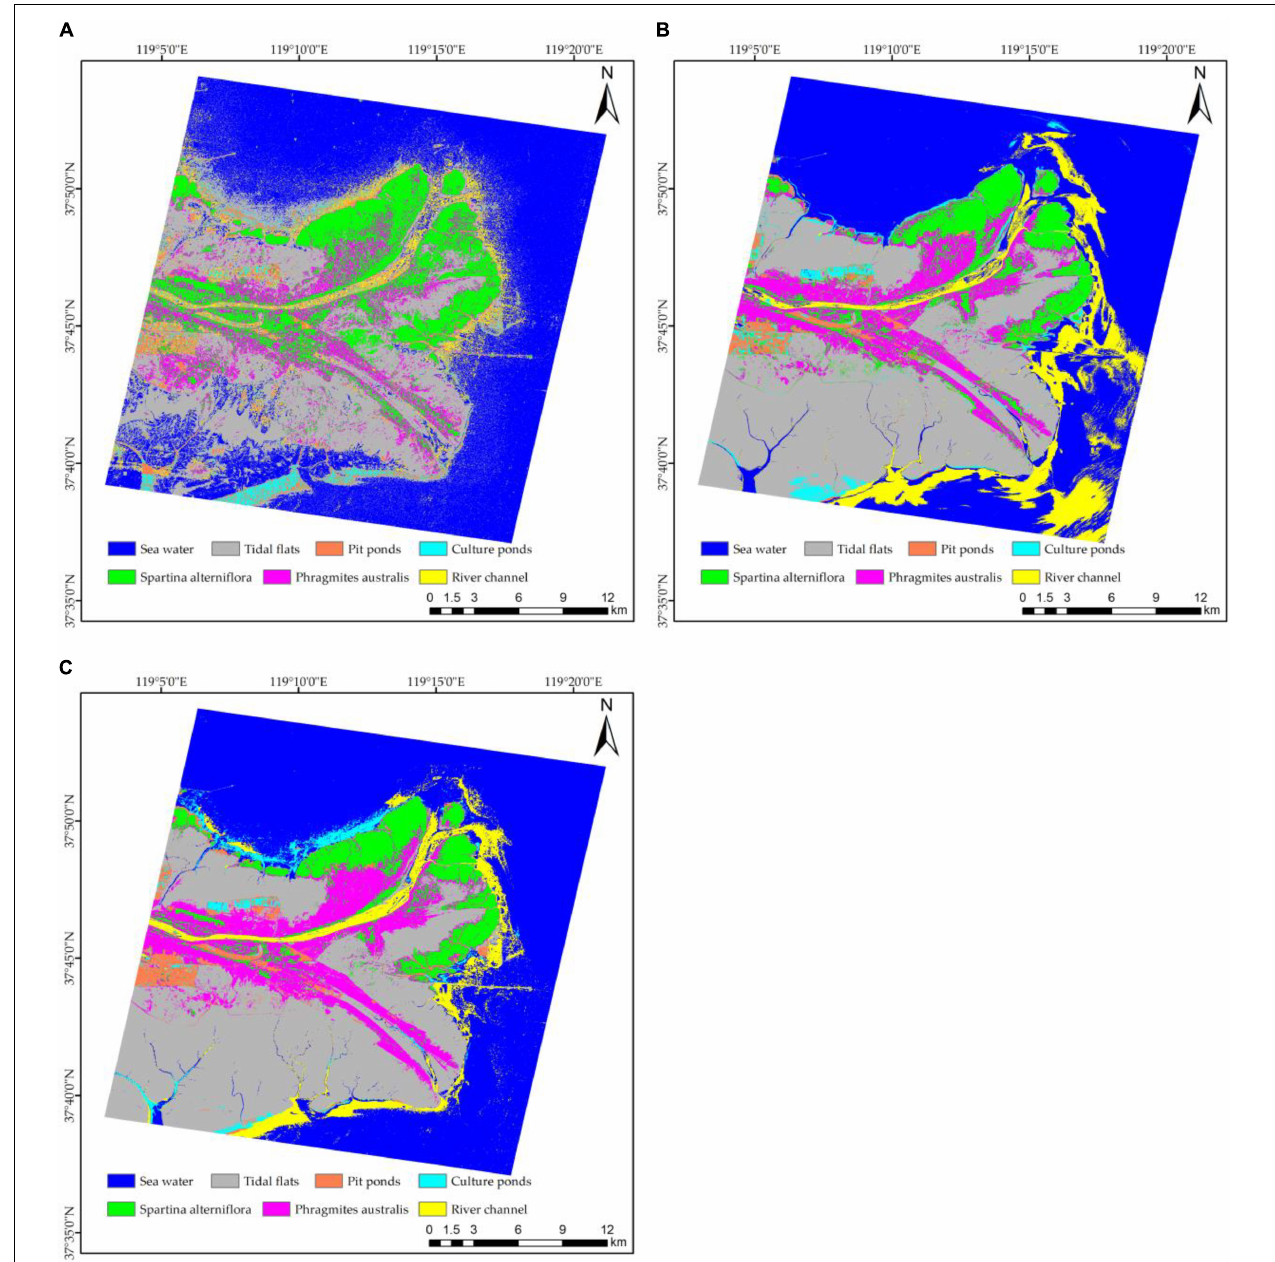
FIGURE 11 | RF classification results based on different characteristics using October 2017 data: (A) The RF with polarimetric features; (B) The RF with spectral features; and (C) The RF with joint